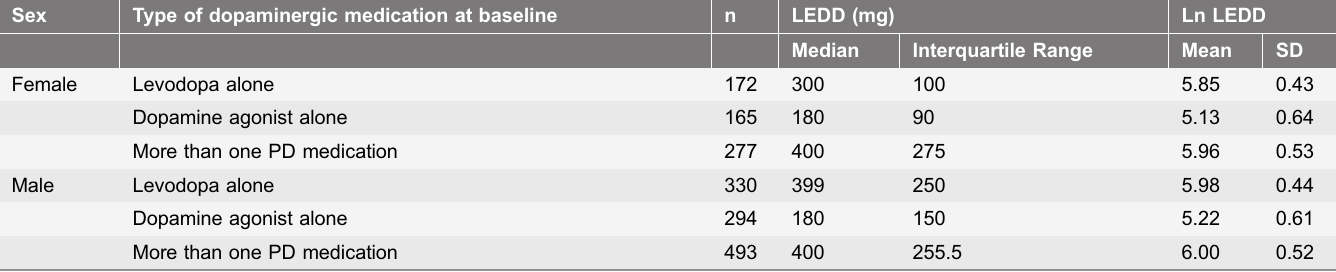
Table 2. Summary statistics of the levodopa equivalent daily dose (LEDD) and natural logarithm LEDD (Ln LEDD) at baseline. Sex